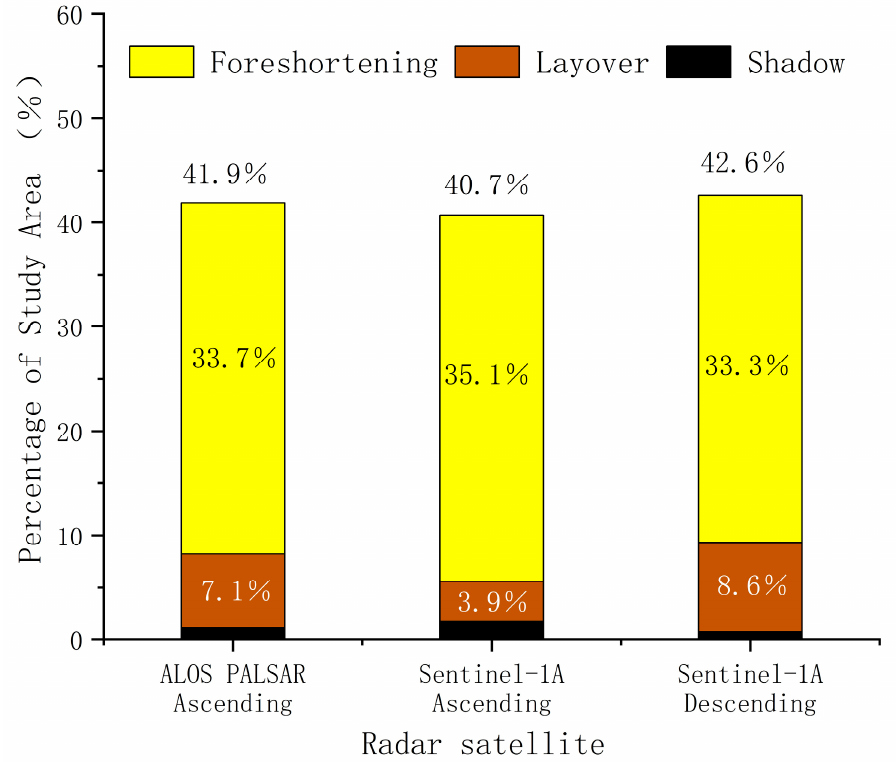
Figure 20. Percentage of different SAR data geometric distortion types in the study area.